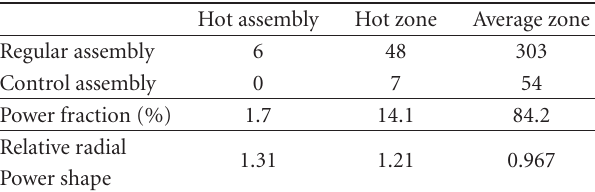
Table 2: Power distribution in core radial zones.